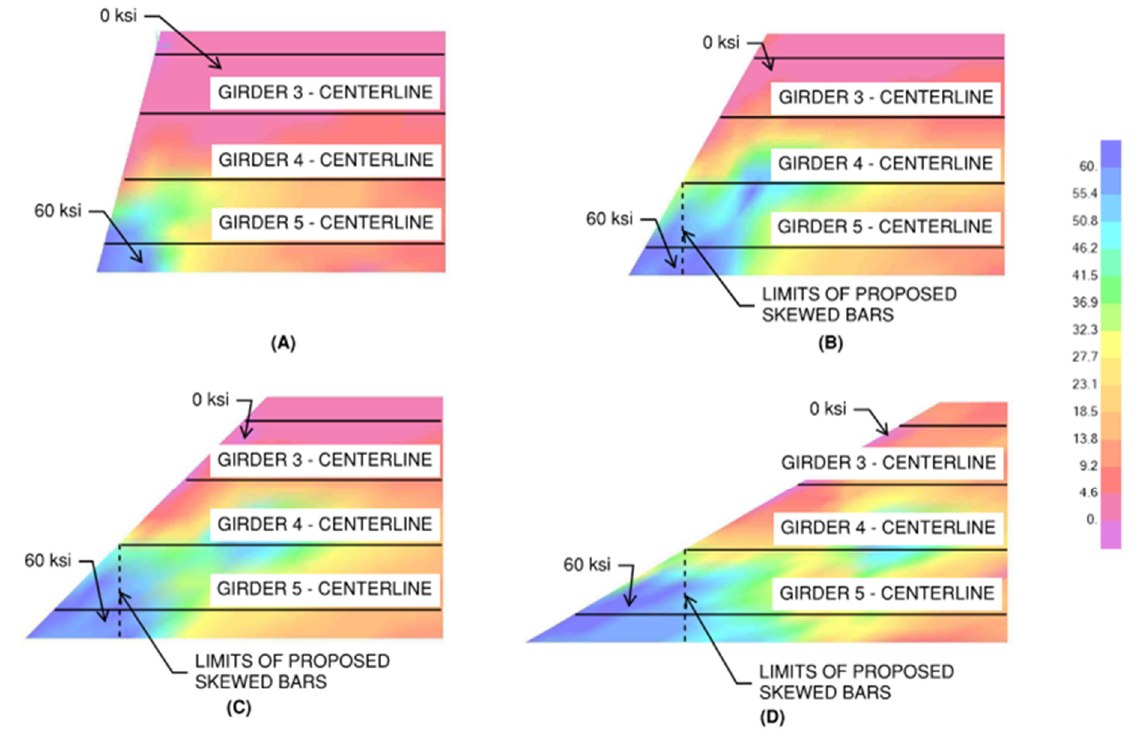
Figure 14. The moment distribution (kip-inch/inch) in the transverse direction for Design Case 1